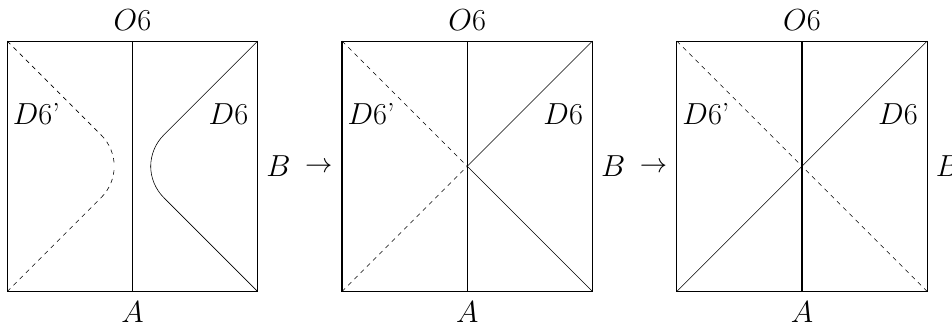
Figure 2 . Schematic depiction of the transition that takes place across the domain wall described in the main text. As we cross the domain wall, the D 6 brane approaches the O 6 plane and reconnects di(cid:11)erently with its orientifold image. In the (cid:12)rst picture, the BF couplings of the D 6 brane and its image cancel; in the third, they add